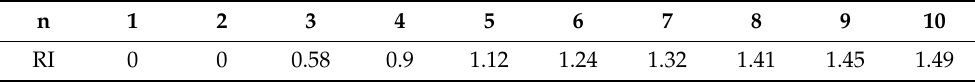
Table 5. Random Indices (Ishizaka and Nemery, 2013).